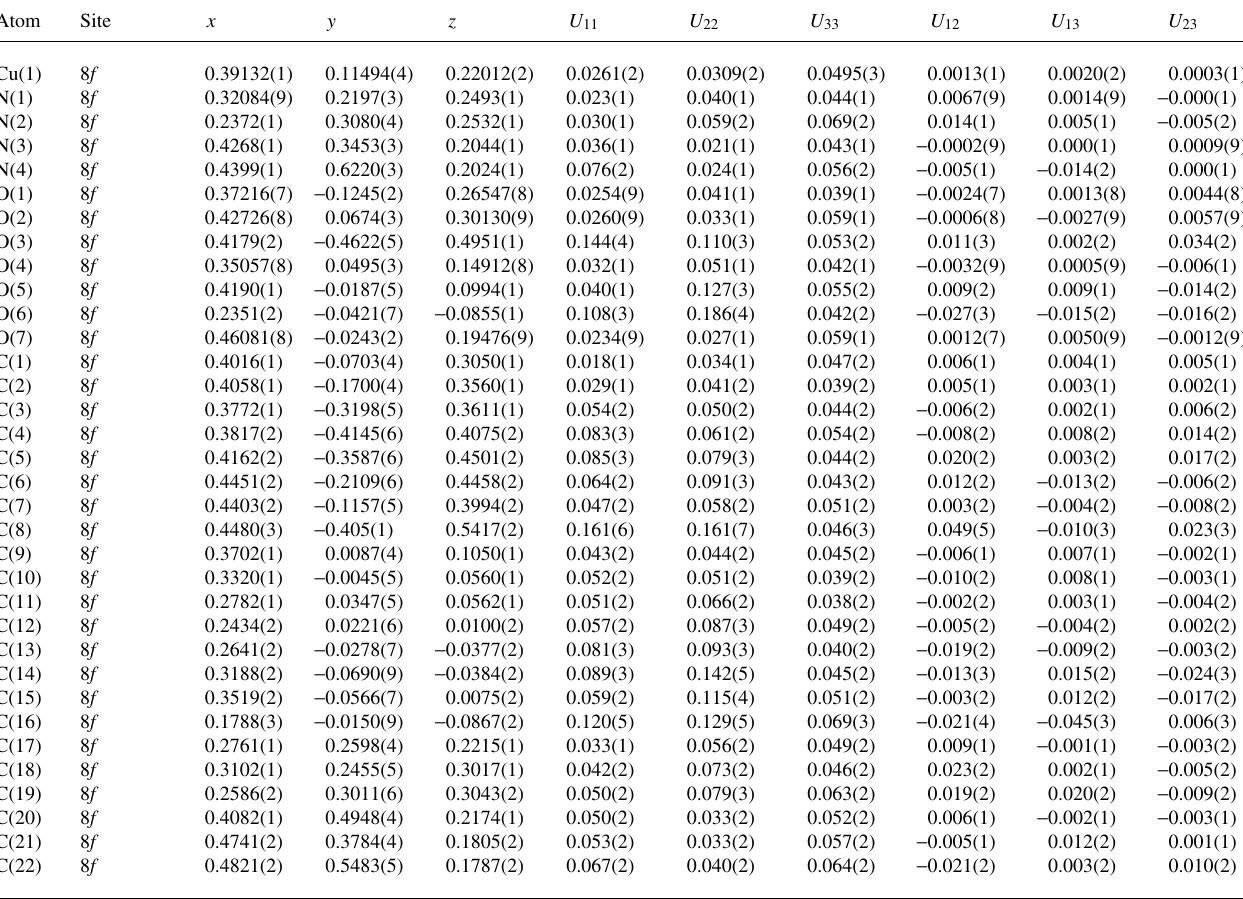
Table 3. Atomic coordinates and displacement parameters (in Å 2 )